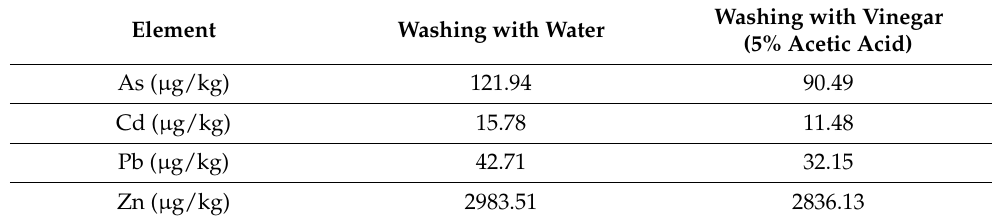
Table 4. The concentrations of heavy metals analyzed in samples of fruit and vegetables washed with tap water and 5% vinegar.